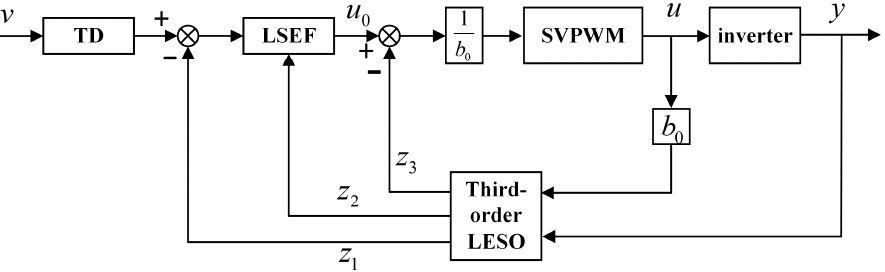
Figure 5. Traditional structure of the linear active disturbance rejection control (LADRC).